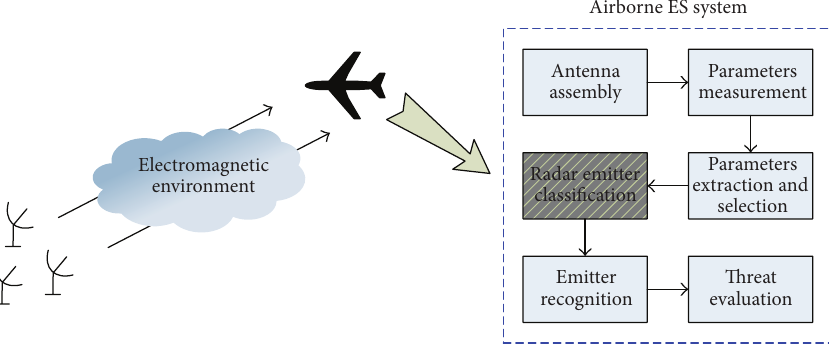
Figure 1: Illustration of the airborne ES system. It consists of antenna assembly, parameters measurement, radar emitter classification, parameters extraction and selection, emitter recognition, and threat